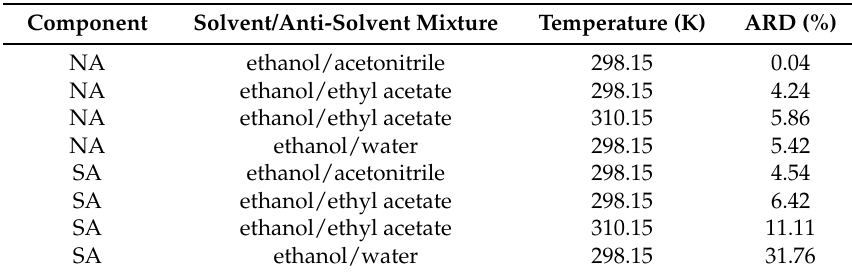
Table 6. Average relative deviation (ARD) of calculated and experimental solubilities of nicotinamide (NA) and succinic acid (SA) in solvent/anti-solvent mixtures.